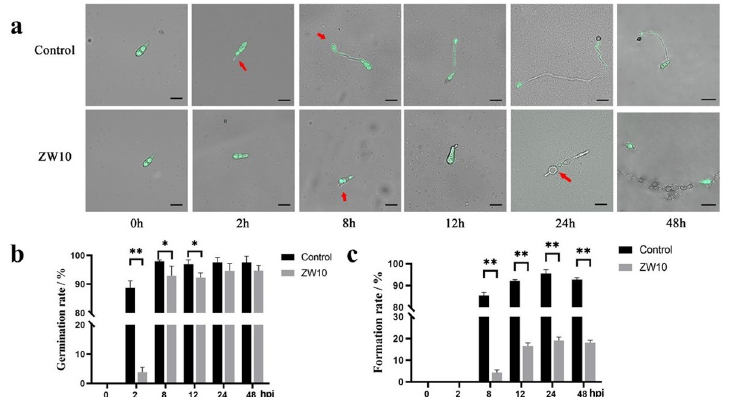
Fig 2. Effects of the antifungal substances of ZW10 on M . oryzae conidia germination and appressorium formation. Morphological changes in conidia of M . oryzae in different periods after 1% CFB of ZW10 treatment (a); germination rate (b) and appressorium formation rate (c) of M . oryzae conidia after ZW10 treatment. Data are presented as means of three replicates ± SD. �� , the treatment difference was significant at P < 0.01. Scale bar, 10 μ m.